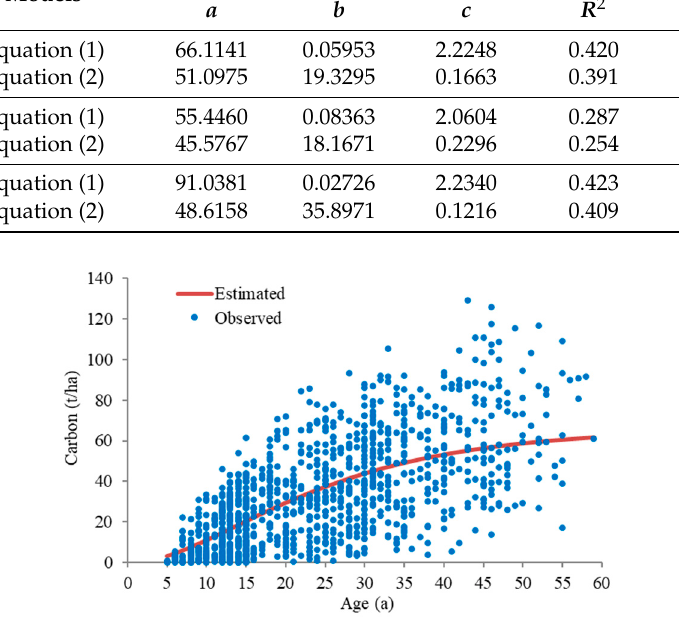
Figure 2. The fitting effect of carbon growth in the Larix plantation.